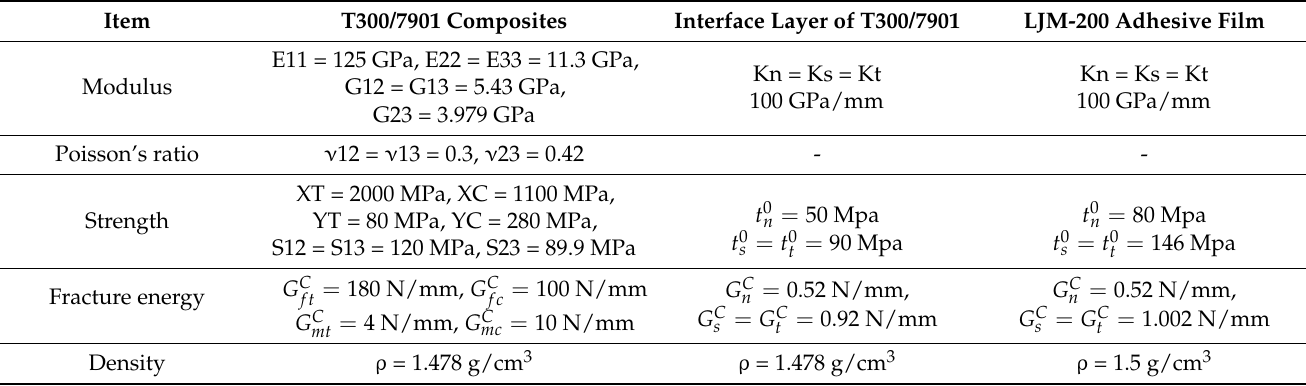
Table 2. Mechanical properties of the used T300/7901 patch-repaired CFRP